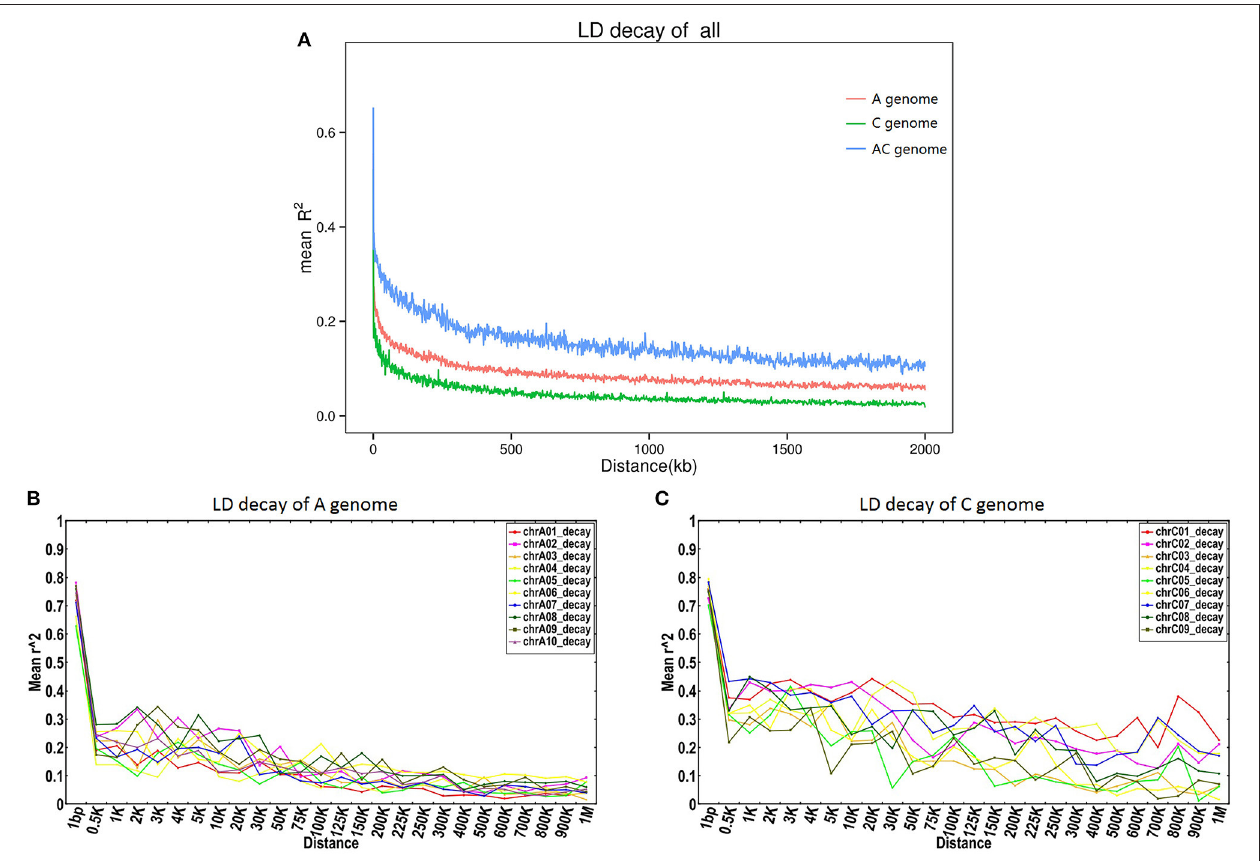
FIGURE 4 | LD decay on the A and C genomes of B. napus. (A) LD decay in the A and C genomes; (B,C) LD decay curves for each chromosome in the A and C subgenomes